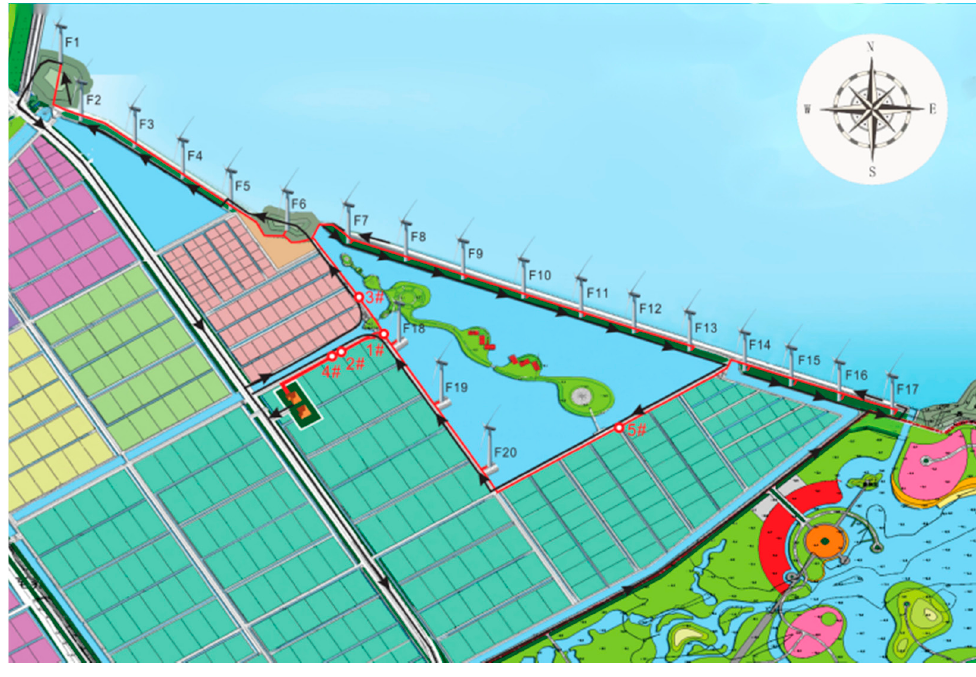
Figure 2. Wind farm . Figure 2. Wind farm.